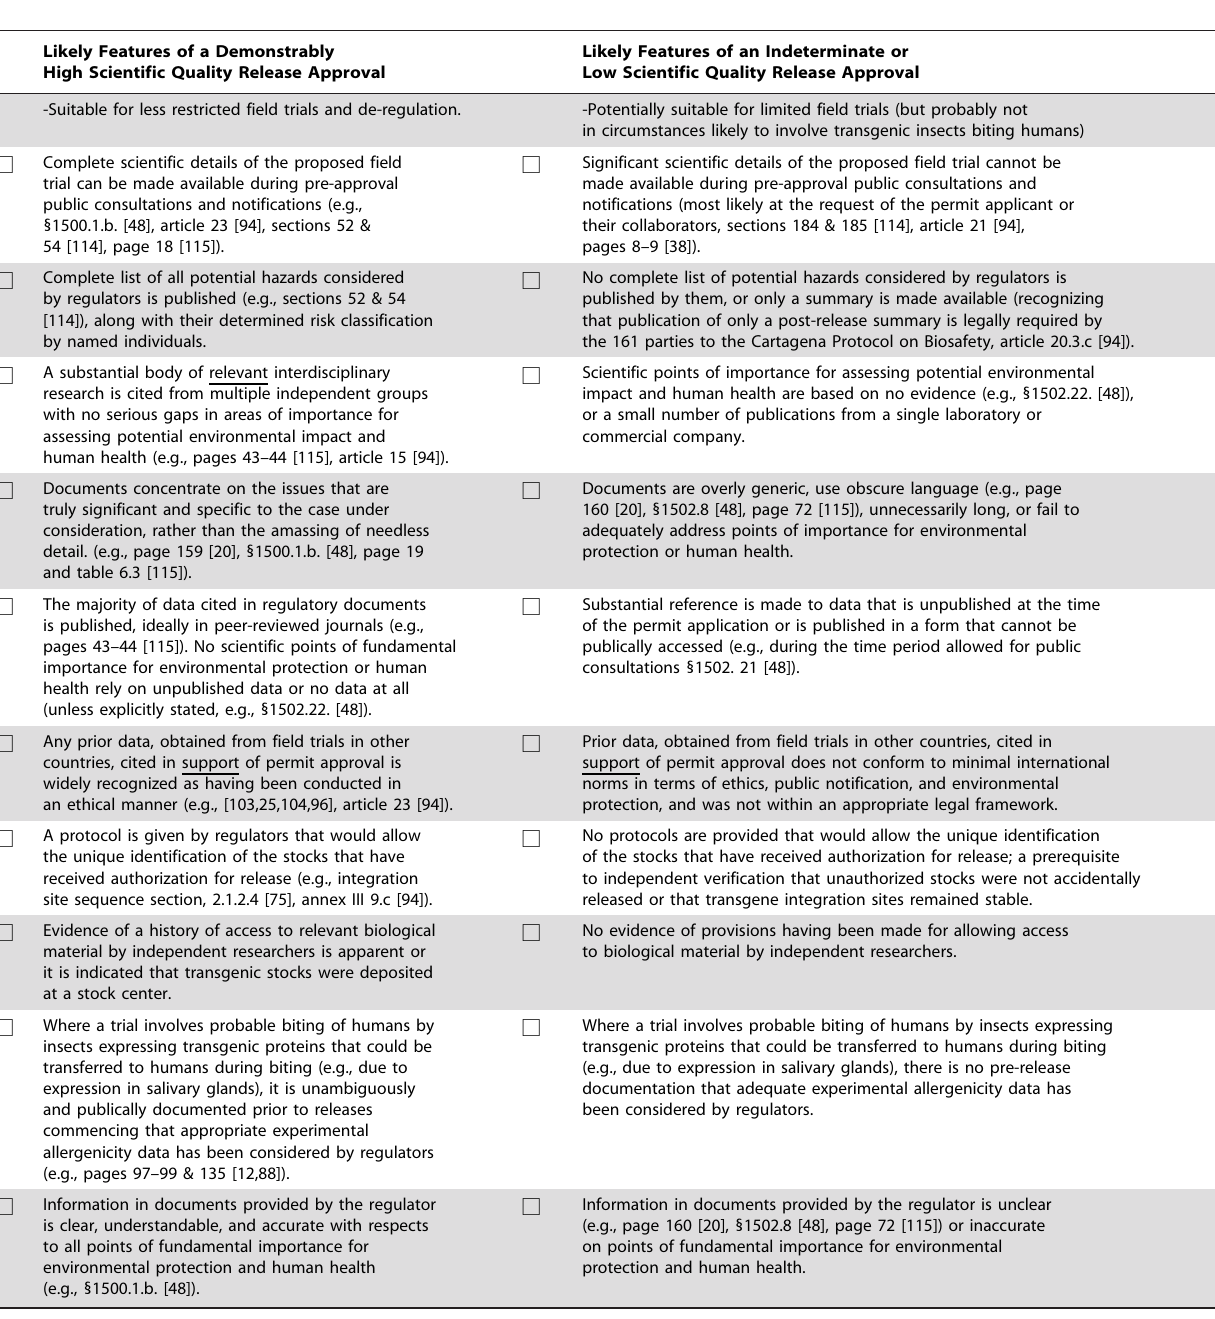
Table 1. Checklist for assessing the scientific quality of approvals for un-caged field trials, based on the examination of documents made publically available by regulators prior to the start of releases.